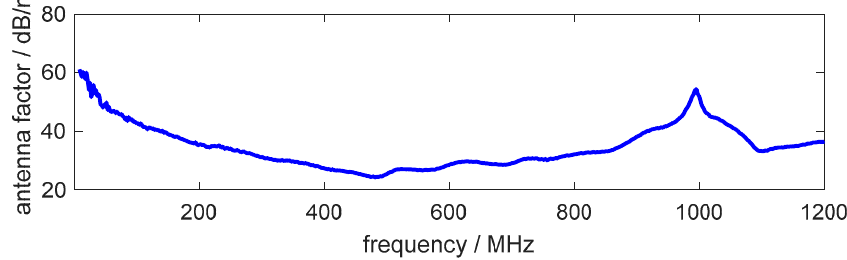
Figure 4. Antenna factor of the used sensor according to Cigré TB 861 [23].